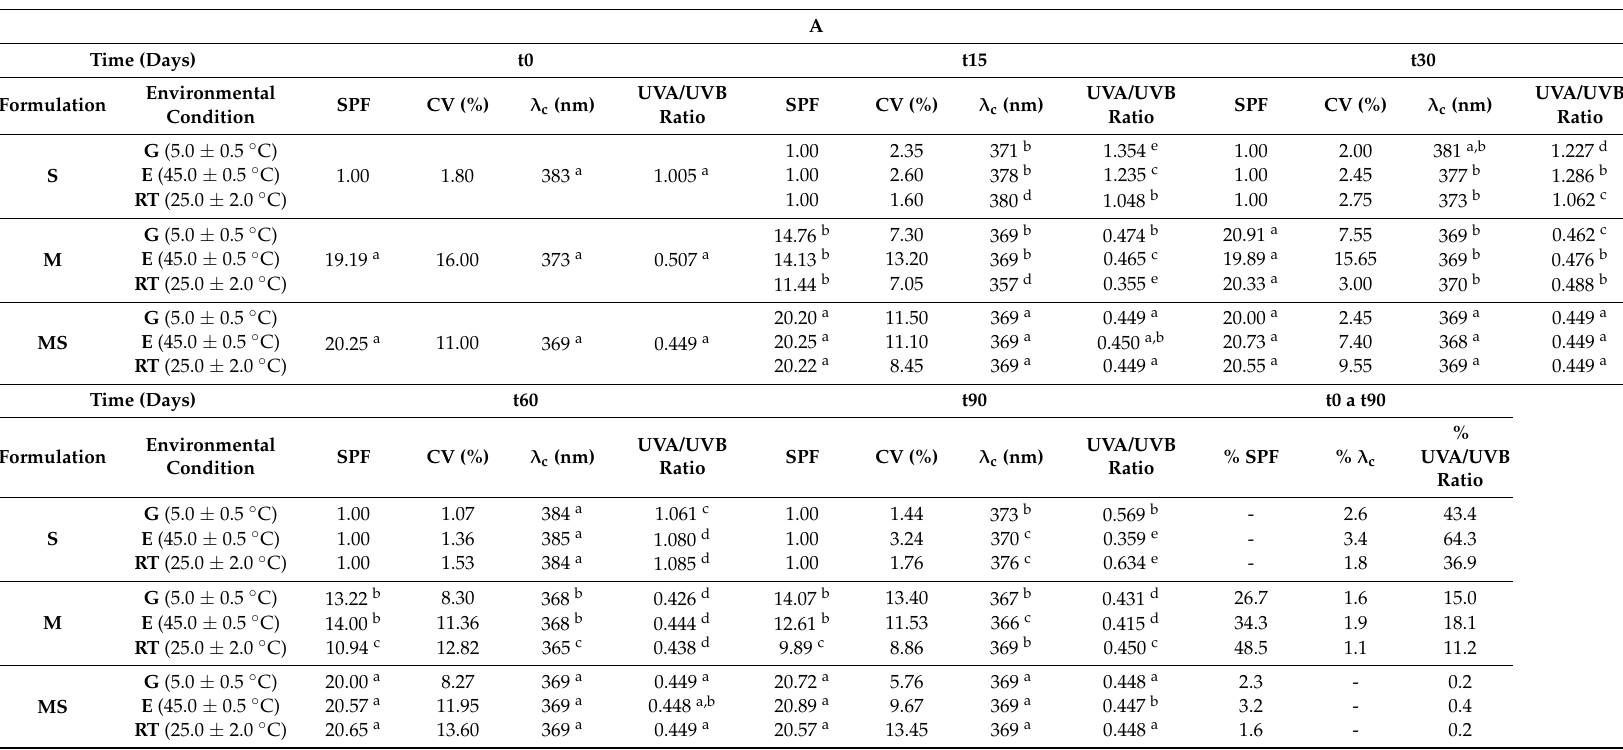
Table 3. Analysis of photoprotective efficacy as assessed by Normal Stability Test of formulations developed with cream base A with addition of chemical and physical filters ( M ), rutin succinate ( S ) or rutin succinate + chemical and physical filters ( MS